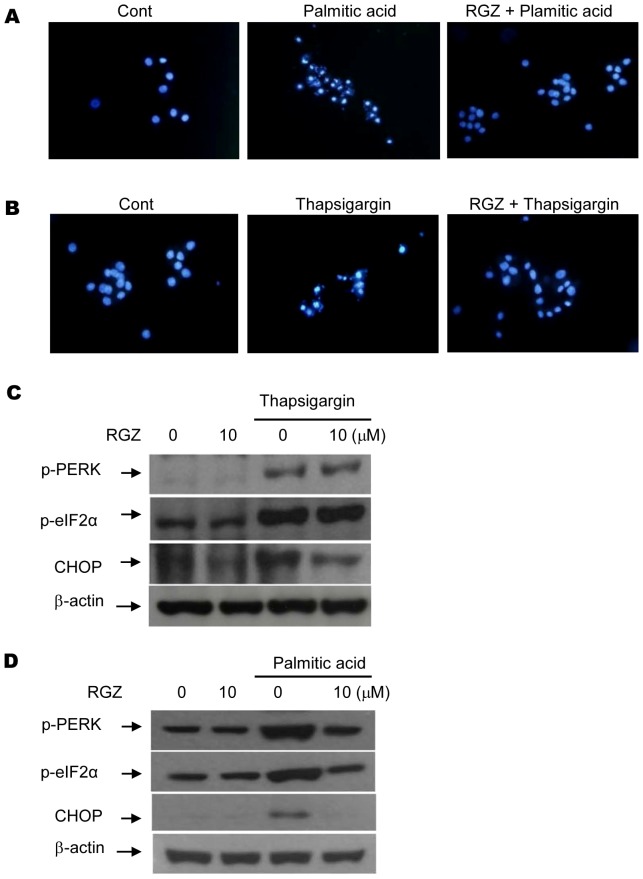
RGZ treatment prevents lipotoxic and ER stress-induced β-cell apoptosis.(A, B) INS-1 cells were pretreated with or without RGZ (10 µM) and challenged with palmitate (1.0 mM) or thapsigargin (50 µM) for 24 h. Cell apoptosis was examined by Hoechst staining. (C) Effect of RGZ treatment on CHOP expression induced by thapsigargin (50 µM). (D) Effect of RGZ treatment on CHOP expression induced by palmitate (1.0 mM).